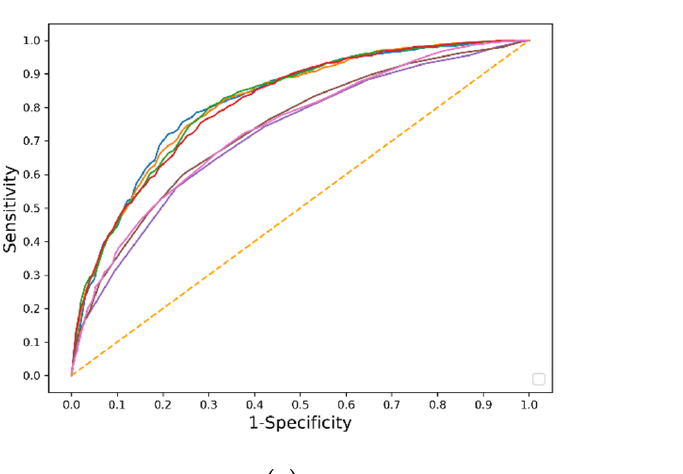
( b ) Figure 3. Area under operating characteristic (ROC) curves for prediction models trained in MIMIC ( a ) and tested in eICU ( b ). Red, RF (0.783, 0.816); Green, XGBoost (0.793, 0.812); Blue, MLP (0.785, 0.810); Orange, LR (0.786, 0.815); Brown, nonrenal SOFA score (0.728, 0.769); Purple, SOFA score (0.717, 0.749); Pink, HELENICC score (0.694, 0.756). 6.4. Machine Learning Algorithm Performance and Comparison with Other Predictive Models in the Secondary Strategy In the pooled dataset, there were 978 and 258 deaths in the training and testing da- tasets, respectively. The XGBoost model achieved the highest AUC value and accuracy (0.823; 95% CI, 0.791–0.854; 0.758) (Table 4). The MLP model performed worse than the other three models (Supplement Table S7). The XGBoost, LR, and RF models showed no evidence of lack of fit with a Hosmer–Lemeshow test ( p > 0.05) in the testing dataset. All four models performed significantly better than the SOFA, nonrenal SOFA, and HELE-